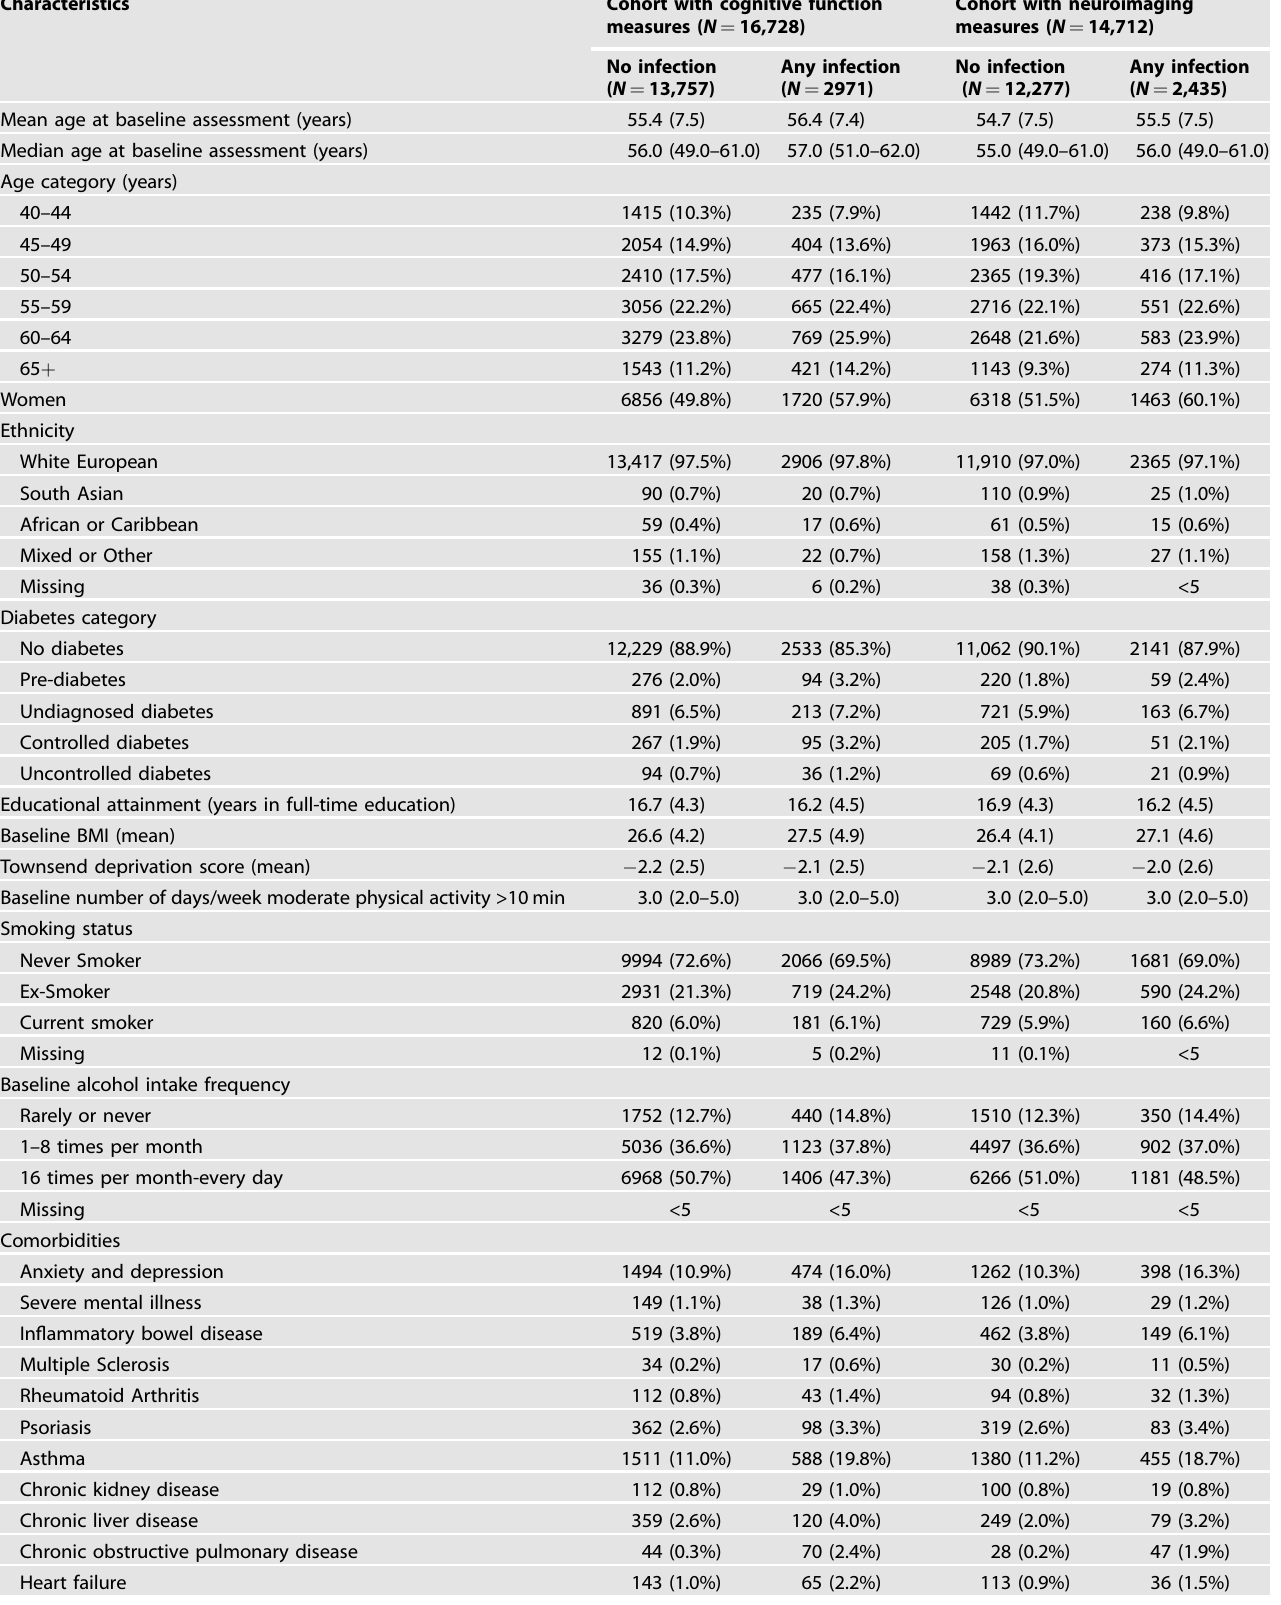
Table 2. Baseline characteristics of participants included in the study with data on cognitive function measures and neuroimaging outcomes, strati fi ed by history of common